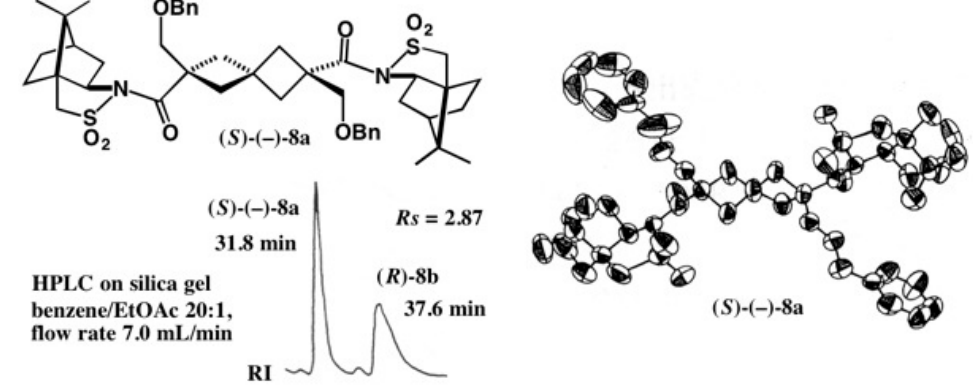
Figure 8. HPLC separation of camphorsultam amides 8a and 8b , and an X-ray ORTEP drawing of the first-eluted amide ( S )-( − )- 8a . HPLC, redrawn from [24]. X-ray ORTEP drawing, reprinted with permission from [23].